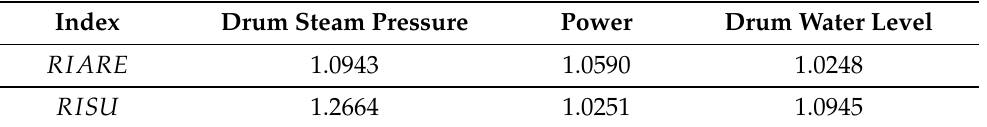
Table 5. Performance indexes for RIARE and RISU in the power reference tracking experiment (MPC is the C 2 and FOMPC the C 1 according to Equations (27) and